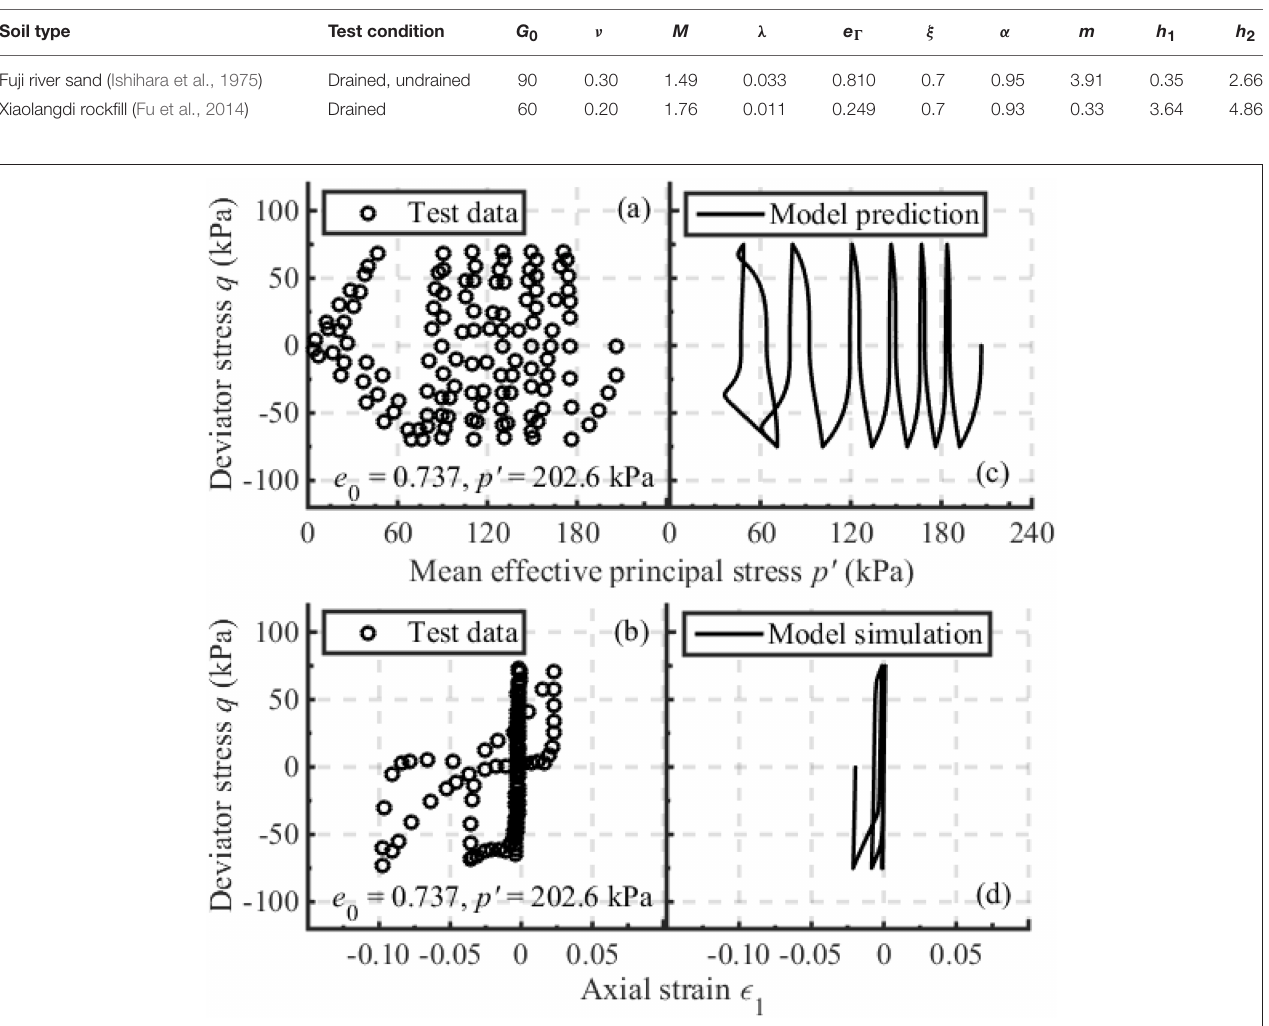
TABLE 1 | Model parameters related to monotonic loading.